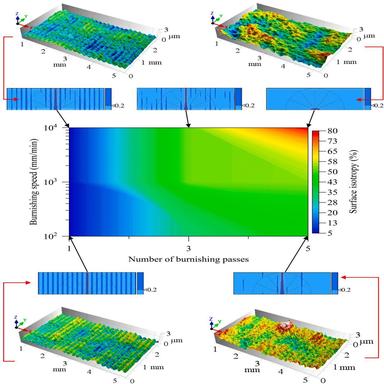
Effect of burnishing number of passes and speed on surface isotropy.